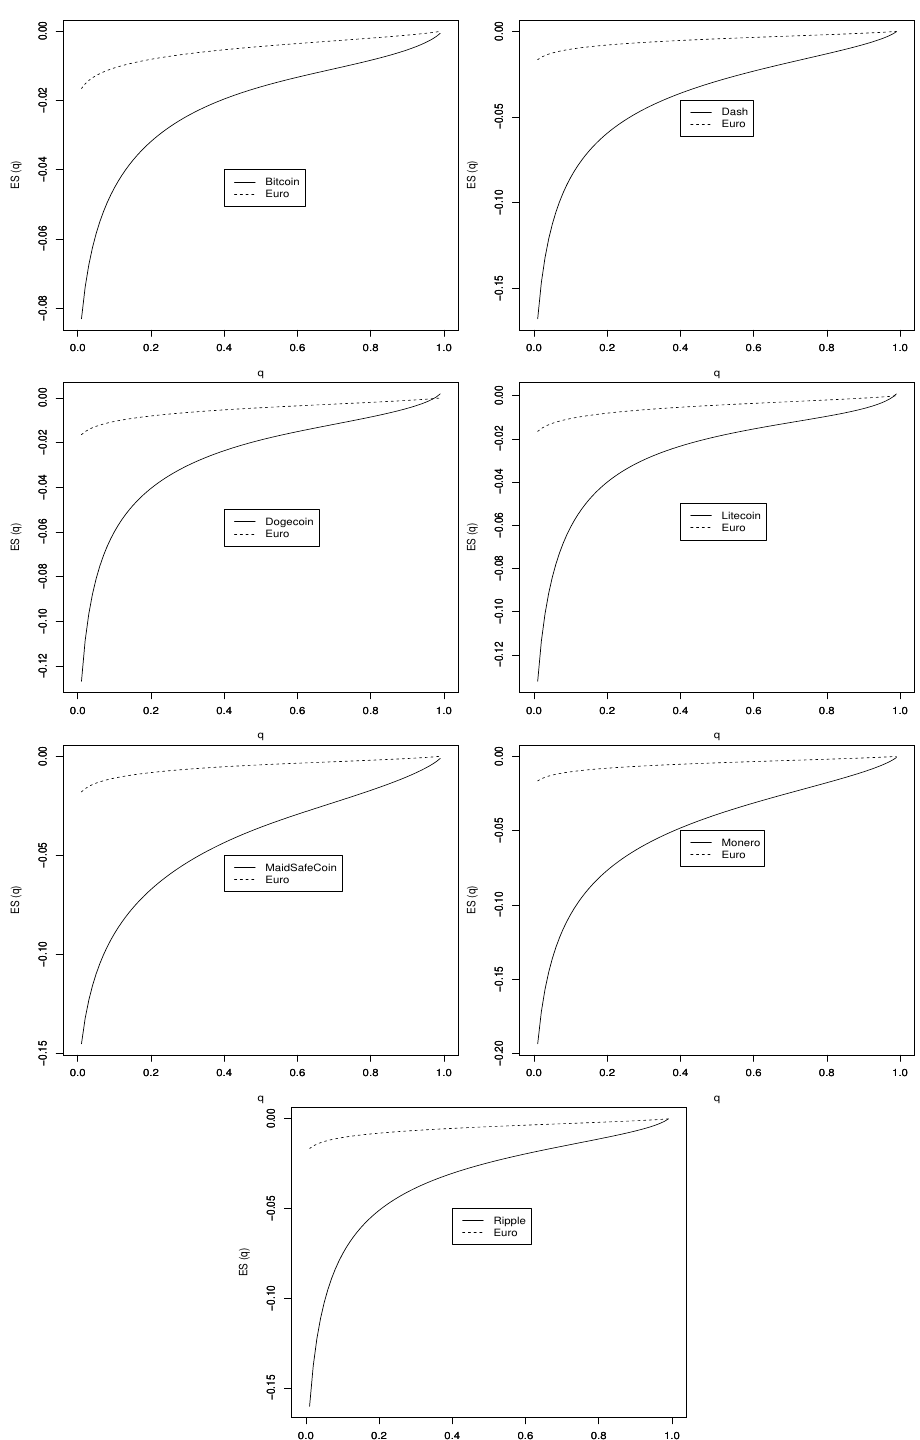
Figure 5. Expected shortfall for the best fitting distributions for daily log returns of the exchange rates of Bitcoin (first row, left), Dash (first row, right), Dogecoin (second row, left), Litecoin (second row, right), MaidSafeCoin (third row, left), Monero (third row, right) and Ripple (last row) from 23 June 2014 until 28 February 2017. Also shown are the expected shortfall values for daily log returns of the exchange rates of the Euro computed using the same best fitting